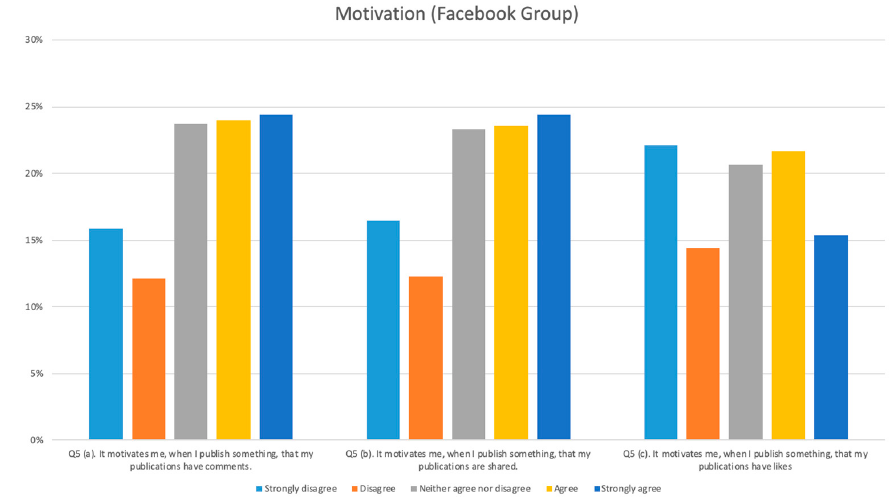
Figure 9. Motivation in Facebook Group (Q5).